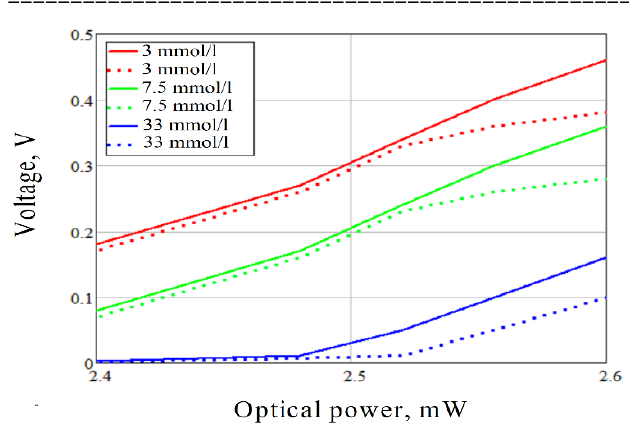
Fig. 4. Dependency of outlet voltage of photodiodes on the power of incident radiation in the system of the optical glucometer with (uniform line) / and without (dotted line) of ellipsoidal reflectors in the forward scattered light.